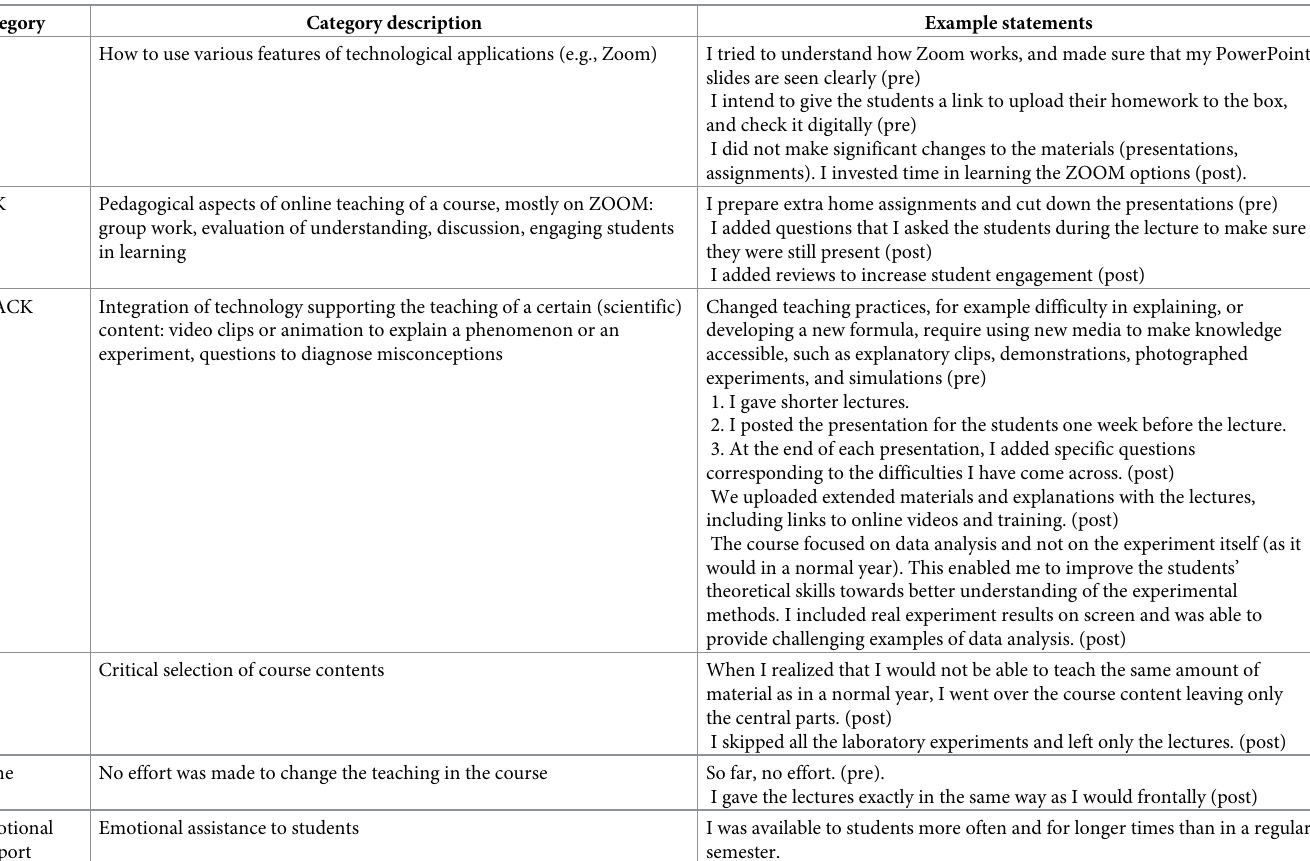
Table 3. Lecturers’ efforts in preparing an online course before and after experiencing online teaching, categorized by TPACK components.